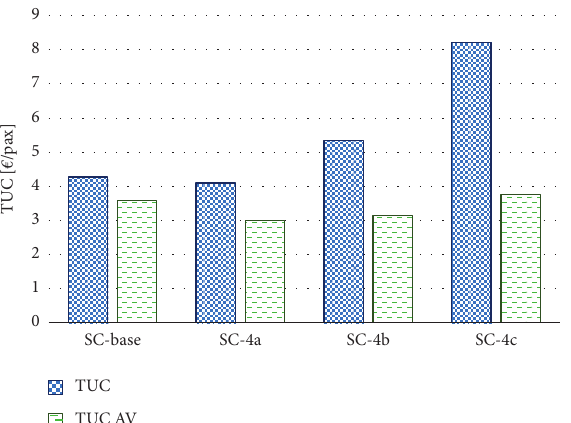
Figure 10: Comparison between transport unit cost (TUC) for traditional and automated vehicles (AV) in Scenario Base (2 vehicles with capacity � 20 seats) and Scenario 4 (vehicle capacityxnumber of vehicles � 8 × 5, 4 × 10, 2 × 20).